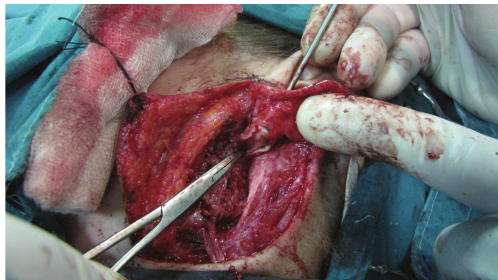
Figure 2: Exposure of the cyst, duplicating the cartilaginous part of the external auditory canal.